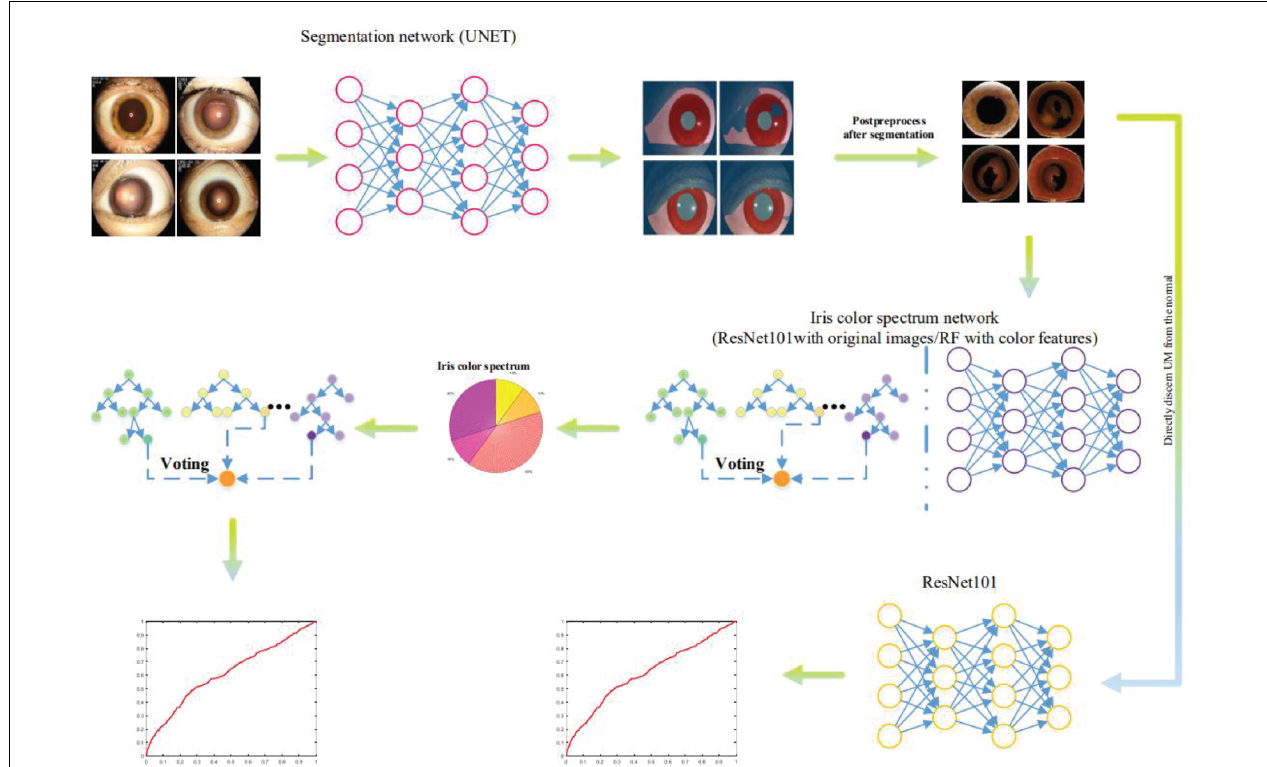
FIGURE 8 | U-NET was used to extract iris regions from slit-lamp images, and then random forest (RF) and convolutional neural network (CNN) were used to extract iris color chromatography as descriptors to distinguish UM patients from nontumor patients. Meanwhile, the extracted iris images were directly input into the CNN network to identify UM patients and nontumor groups.